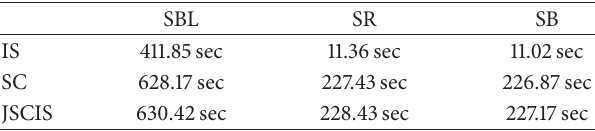
Table 2: Solution times in seconds.